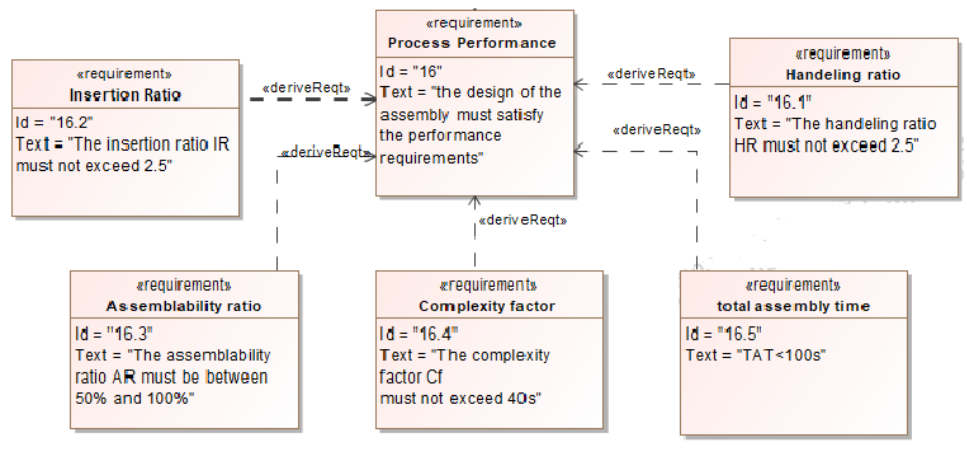
Figure 5. Process performance requirements of the speed reducer.